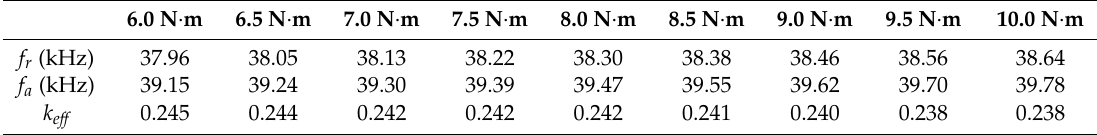
Table 2. Simulation results in the presence of pre ‐ loading torque.